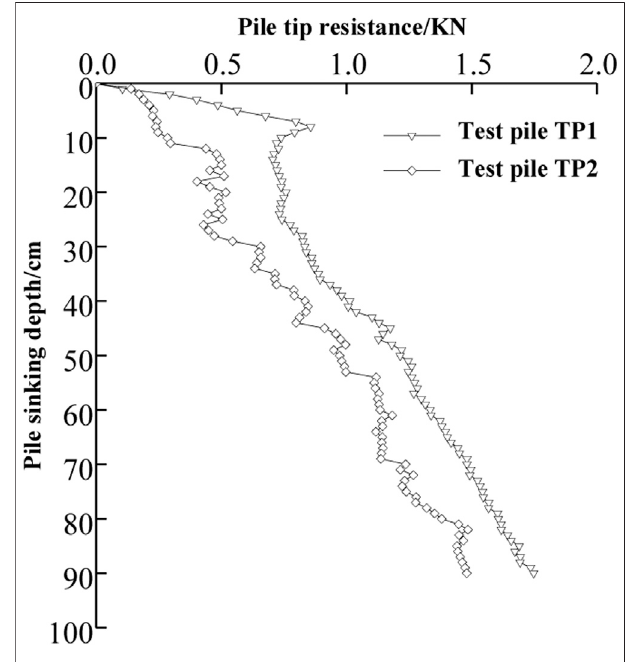
FIGURE 8 | Change of pile end resistance during pile jacking.